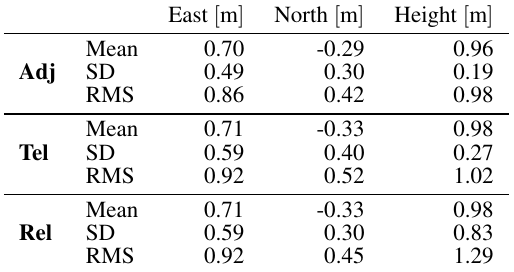
Figure 4. Cloud-to-cloud distances of the “adjusted”, “telemetry”, and “relative” point clouds with respect to the Table 4. Statistics of the differences between the image centres reference one. On the right side of each colourbar, the histogram of projection estimated by the “adjusted” (Adj), “telemetry” showing the distance distribution is depicted. The colourbar is (Tel), and “relative” (Ref) solutions and the ones of the reference saturated to 1 . 2 m (disregarding less than 1% , 3% , and 15% of solution. points,